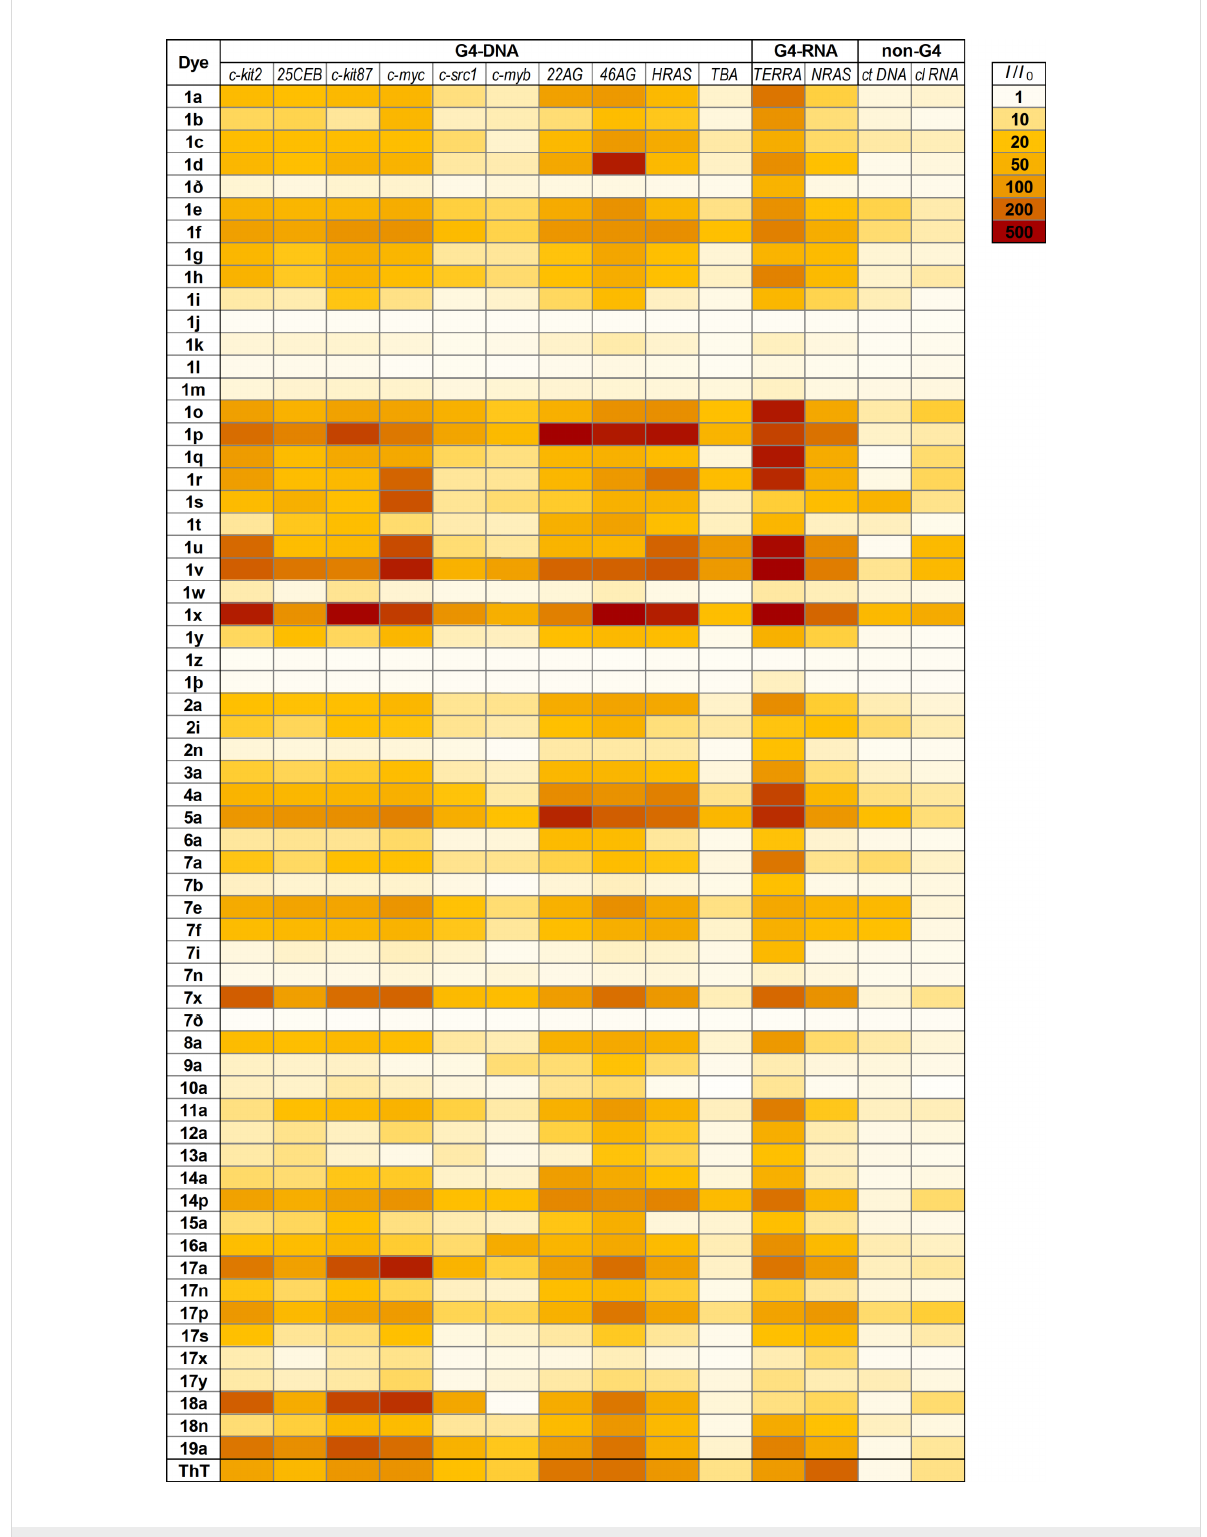
Figure 5: Heat map of the relative emission intensity enhancement ( I / I 0 ) of styryl dyes and thioflavin T (ThT) ( c = 2.5 µM in K-100 buffer) in the pres- ence of 2 molar equiv of G4-DNA (46AG: 1 molar equivalent), G4-RNA, or ct DNA and cl RNA controls used at equivalent nucleotide concentration. Darker cells indicate higher I / I 0 values (see legend). For the numeric data, excitation and emission wavelengths see Supporting Information File 1, Table